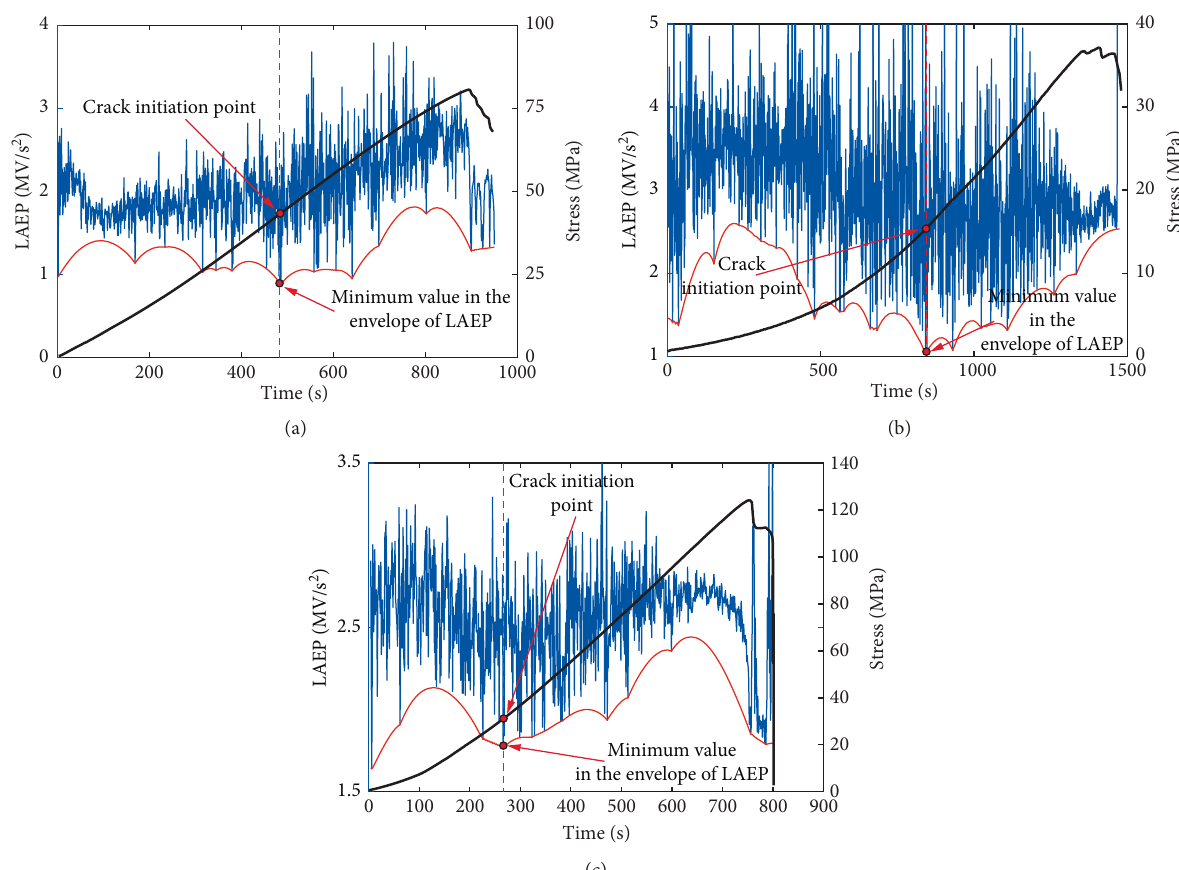
Figure 6: Time-varying LAEP, lower envelope, and stress distribution of the specimens under compression. (a) Tight sandstone. (b) Loose sandstone. (c)